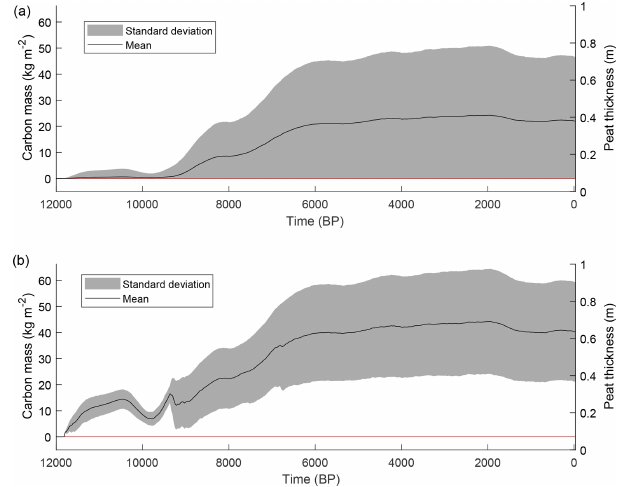
Figure 9. Simulated mean peat thickness/carbon mass and standard deviation for all grid points (a) and for the grid points with a peat cover (b)